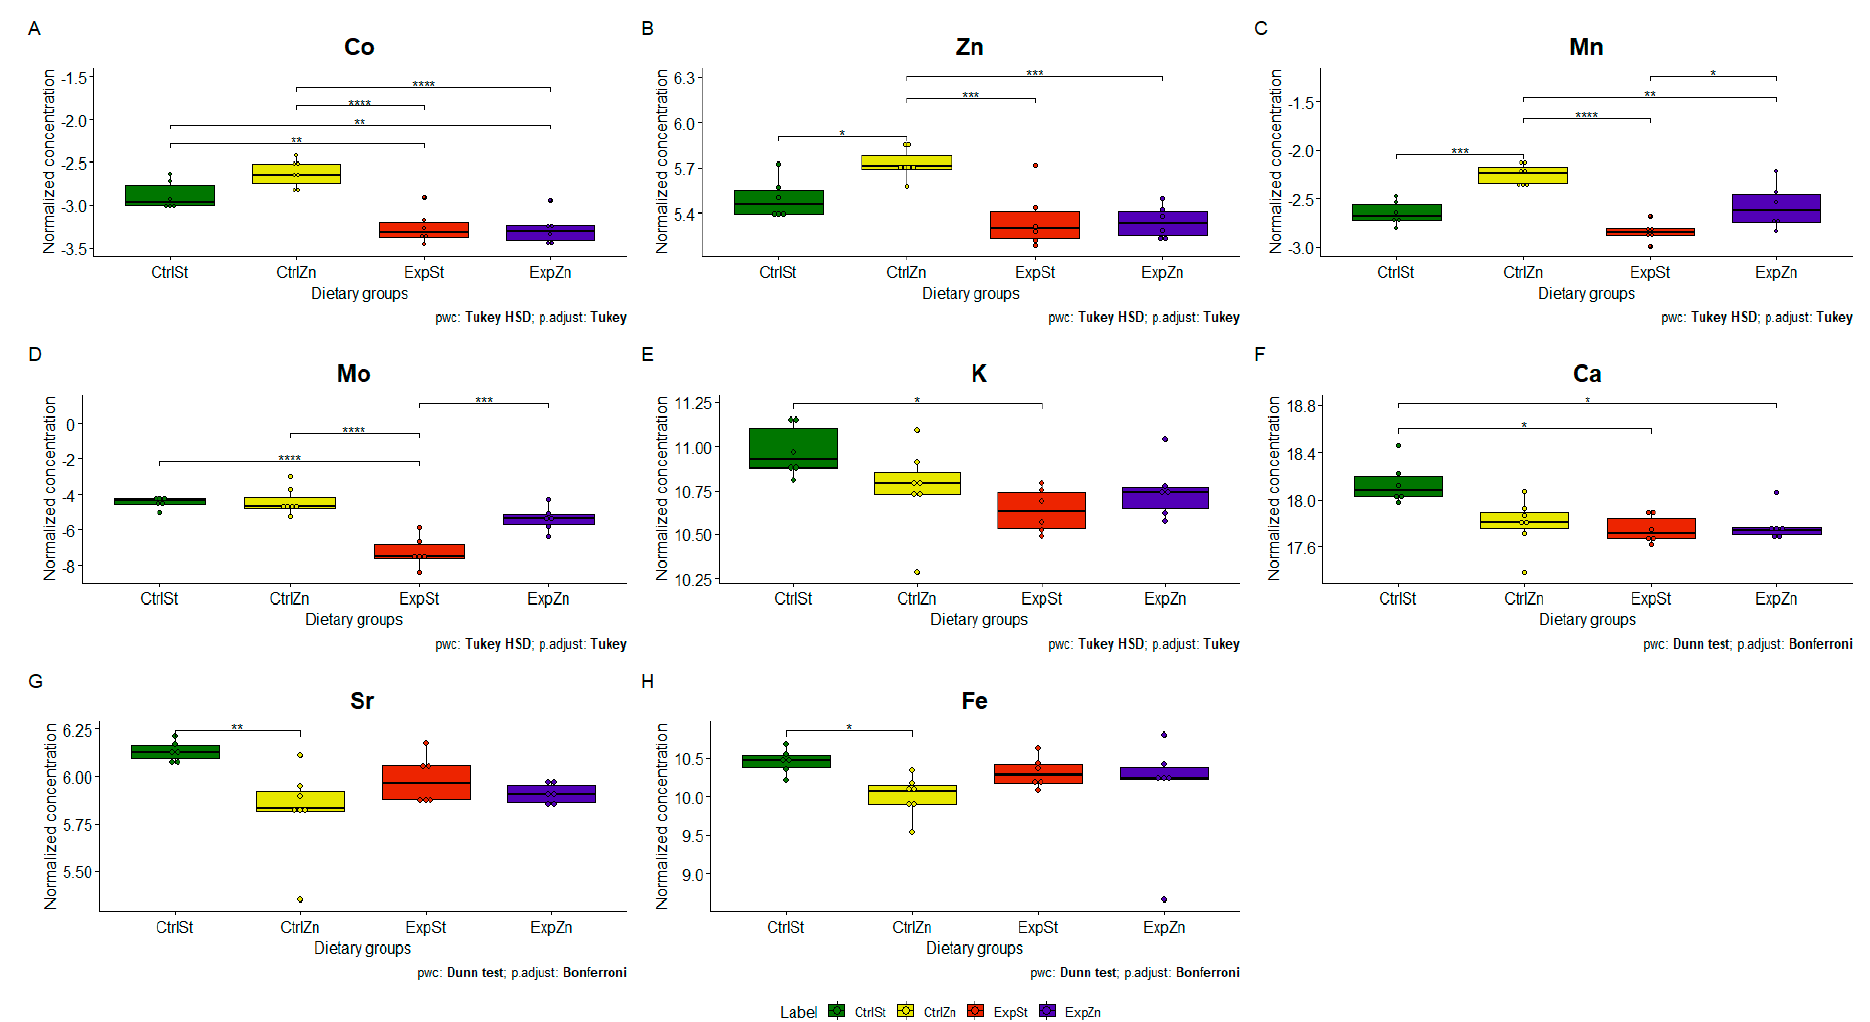
Figure 4. Analysis of concentrations of elements in four experimental groups: ExpSt—experimental standard diet with LNCaP (violet boxplot), CtrlSt—control standard diet without LNCaP (yellow boxplot); ExpZn—Zn supplementation diet with LNCaP (green boxplot); CtrlZn—Zn supplementation diet without LNCaP (red boxplot); p -value: <0.0001 ****, 0.0001–0.001 ***, 0.001–0.01 **, 0.01–0.05 *.